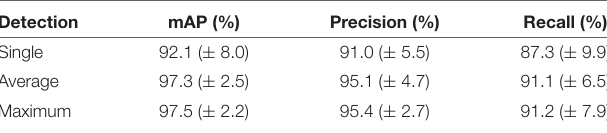
TABLE 4 | Multi-frame detector